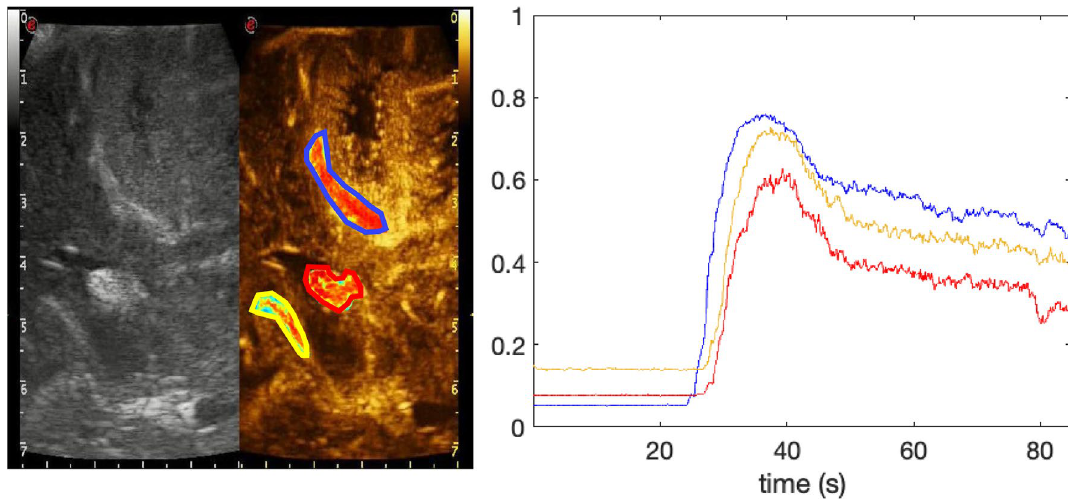
Figure 5. Timing differences between different vascular and cerebral structures. Left panel: B-mode and CEUS images on a still frame. The 3 regions of interests selected using the analysis software are displayed in color on the CEUS image using colorimetric scale for MBs concentration and circled according to the plot—sulcal artery, blue—choroid plexus, red—basal vein, yellow. Right panel: Time-intensity curve plot. Continuous evaluation allowed the detection of MBs arriving in a sulcal peritumoral artery following an orthograde flux, in one of the deep basal veins and successively in a highly vascularized structure such as the choroid plexus. The plotted graphs show this difference as a delayed shift in the PE of the different structures with a delay of 1 s from each one as seen on the upper scale.